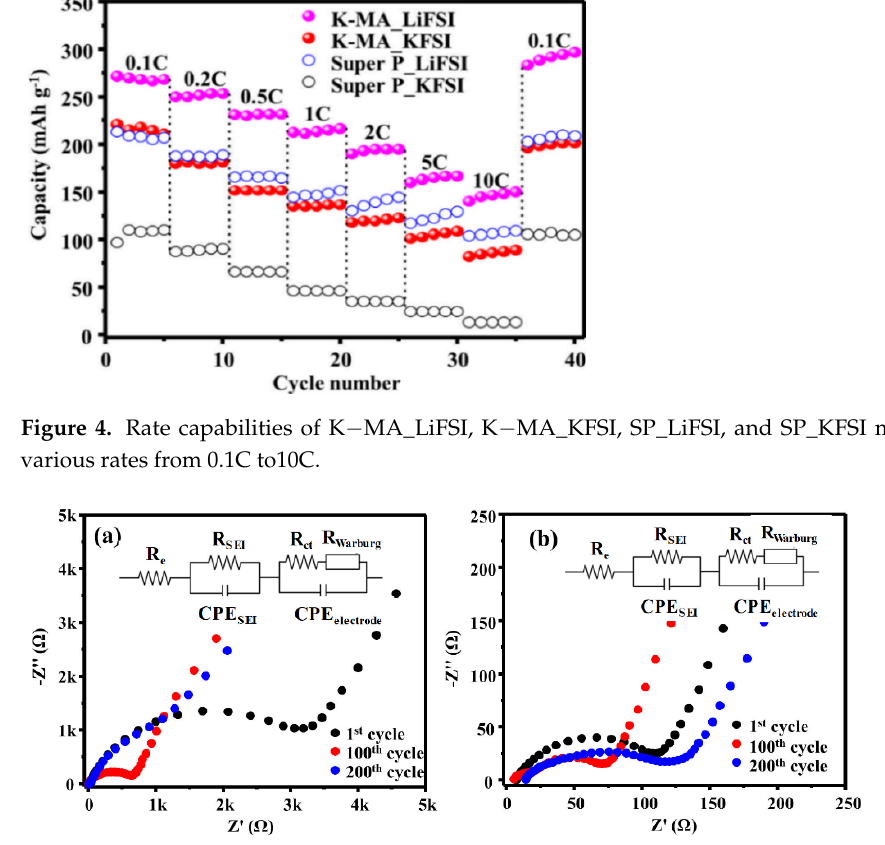
Figure 5. EIS plots of K − MA as ( a ) KIB and ( b ) LIB electrodes; first, 100th, and 200th cycles, measured from 1 MHz to 10 mHz. Table 2. Resistances determined from EIS spectra of electrodes after first, 100th, and 200th cycles. K-MA_KFSI K-MA_LiFSI Cycle No.